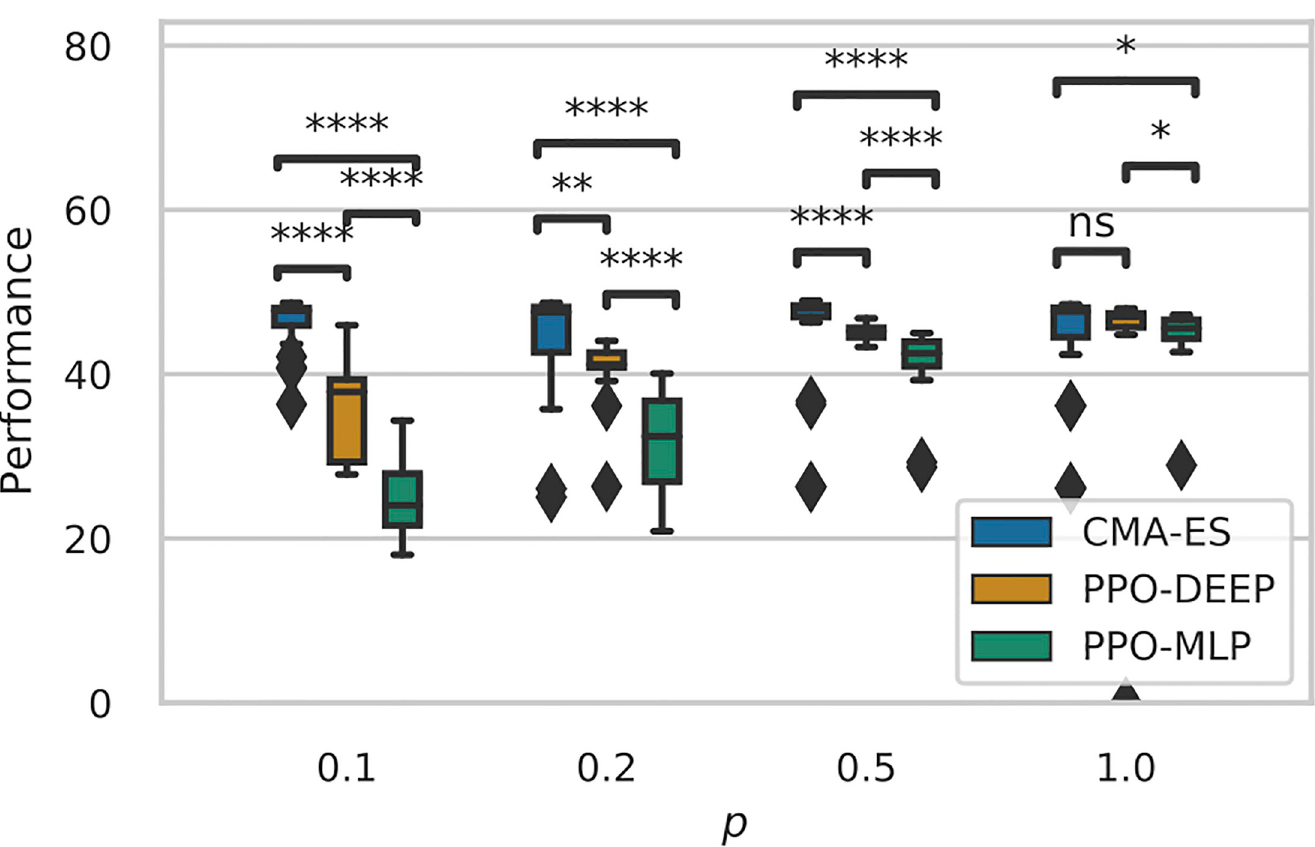
Fig 4. Performance of the best policies (medians and quartiles) from CMAES, PPO-DEEP and PPO-MLP with p 2 {0.1, 0.2, 0.5, 1.0} after re-evaluating policies for 1000 episodes without learning. Two-tailed Mann-Whitney U-test, n = 24 marked as: � for p -value < 0.05, �� for p -value < 0.01, ��� for p -value < 0.001 and ���� for p -value <